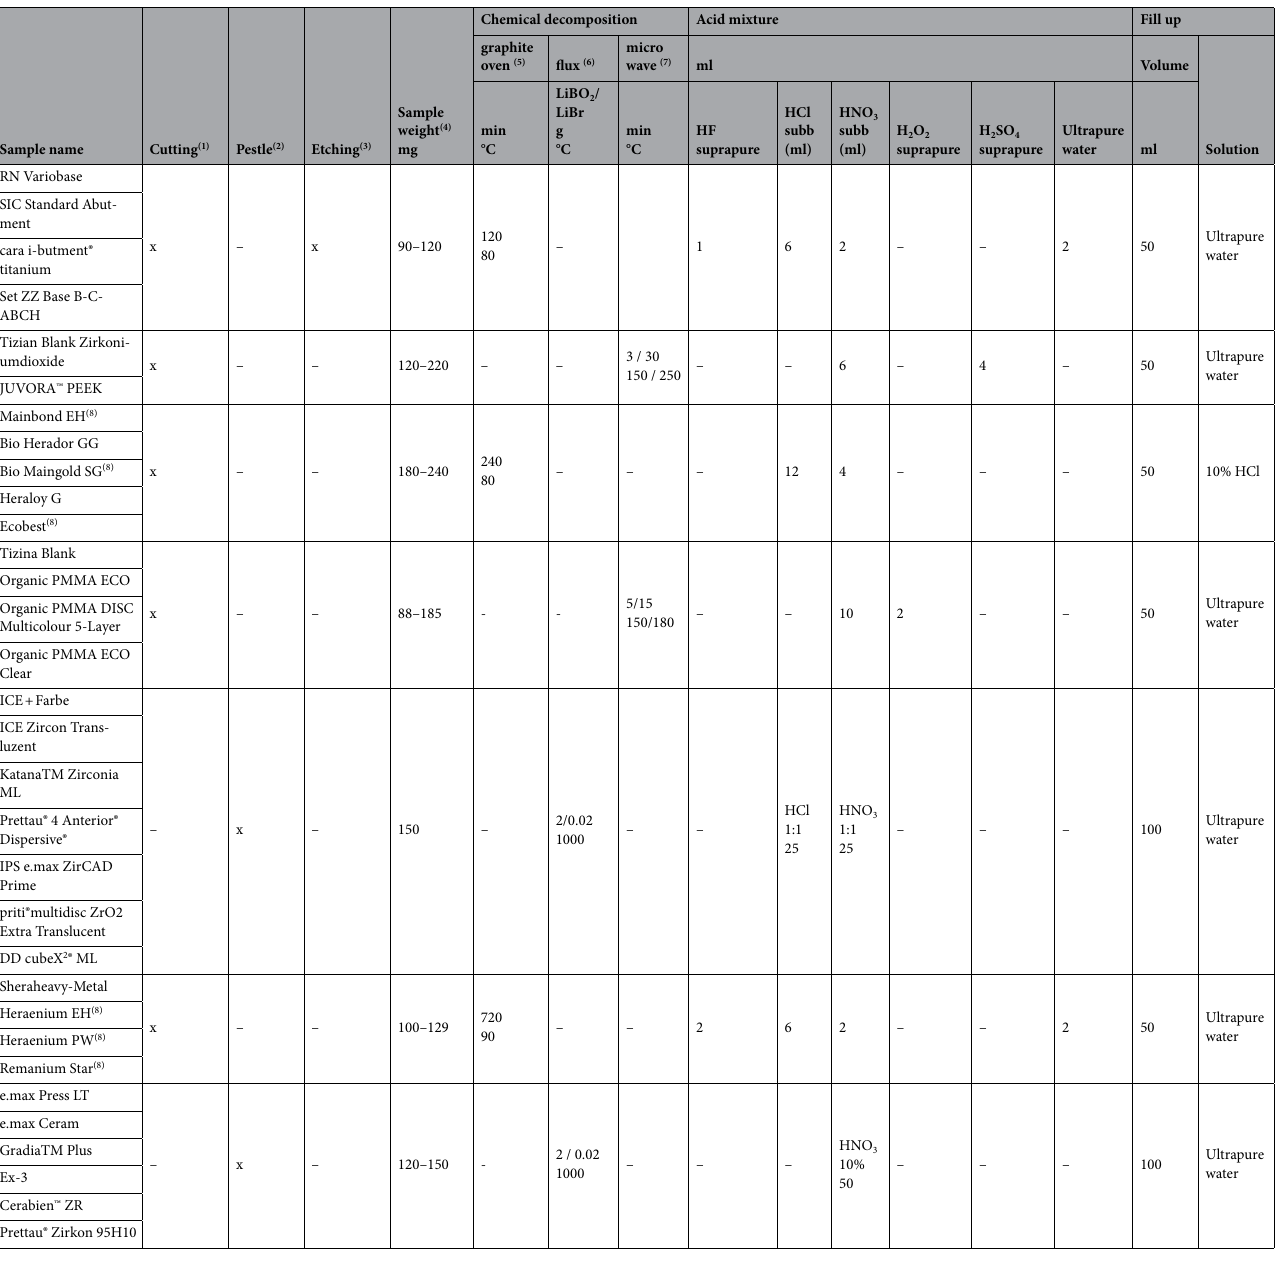
Table 2. Preanalytical preparations and chemical digestion for each included group. (1) cutting edge made of steel (1 BR/6, Peddinghaus, Germany). (2) mortar mill made of Si3N4 (SRS-2000, Analysen Geräte